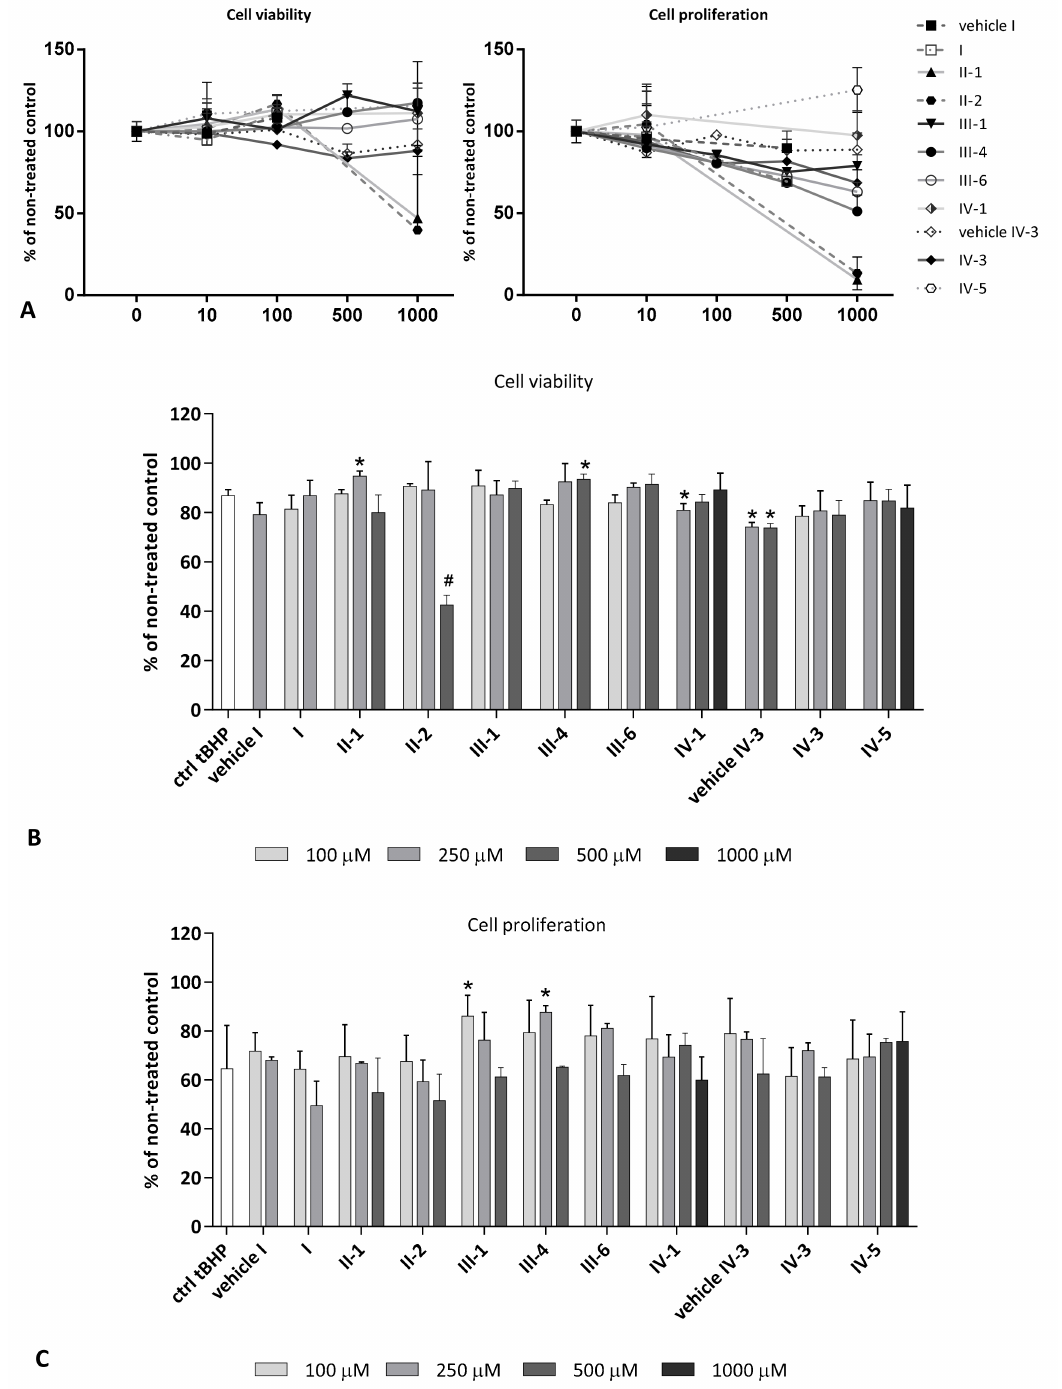
Figure 4. Cell viability (EZ4U assay) and proliferation (BrdU assay). ( A ) just DHPs without tBHP; ( B ) and ( C ) cell cultures treated with 50 µ M tBHP. Results are expressed as a percentage of non-treated control. Values are given as mean ± standard deviation; n = 4. In comparison to the treatment control (ctrl tBHP), statistically significant differences are shown as follows: * p < 0.05; # p <